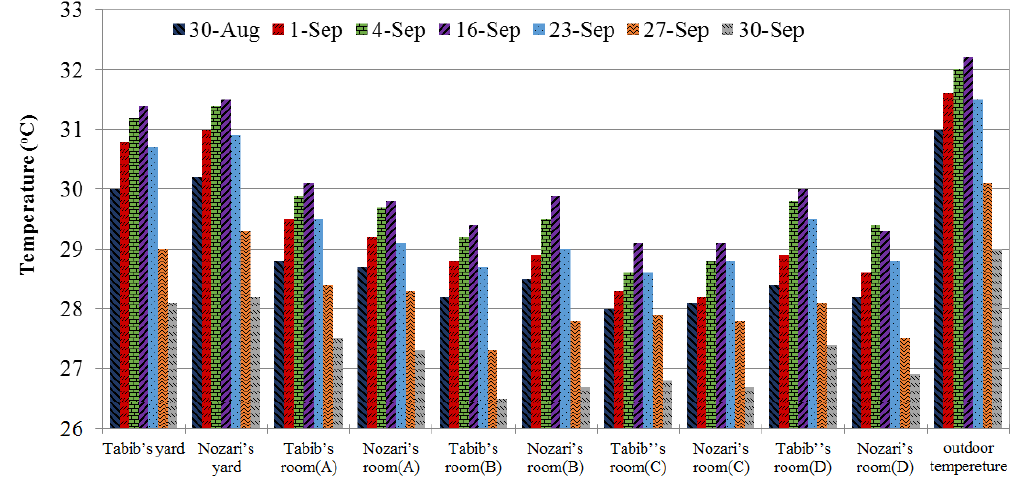
Figure 11. Temperature of rooms measured for different days and different spaces at 1:00 p.m.